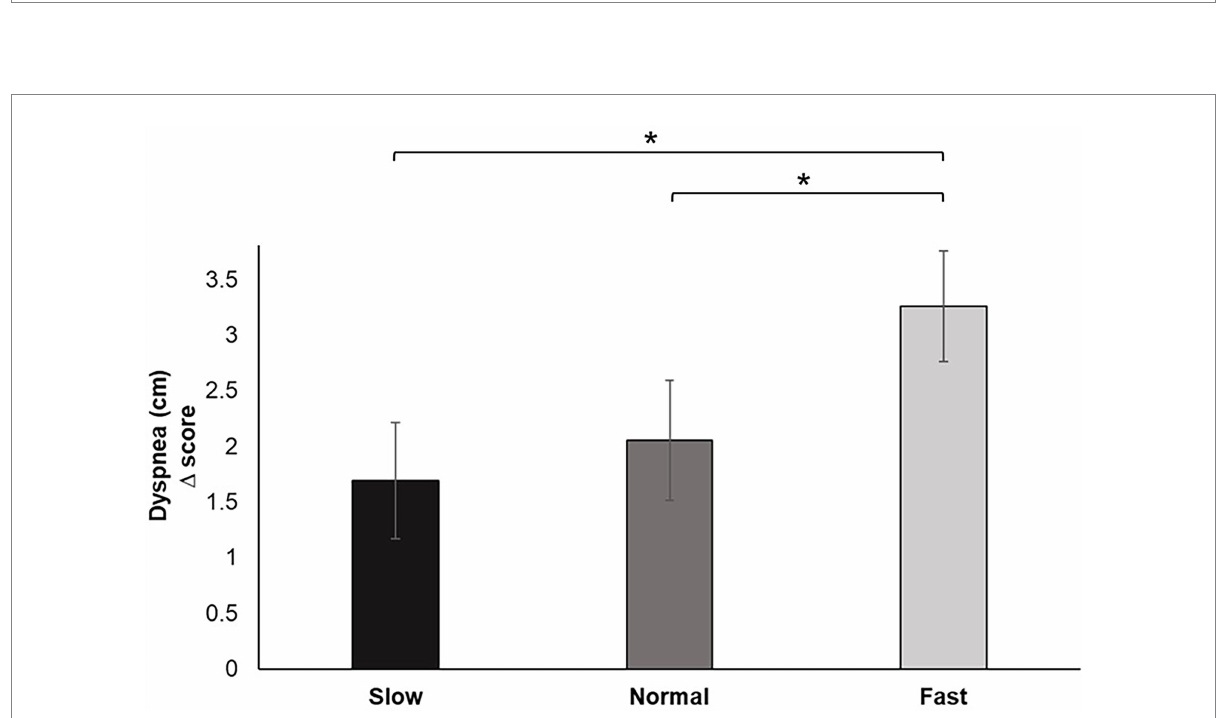
FIGURE 7 Dyspnea change scores for each breathing frequency condition in centimeters (cm) on a scale from 1–10. Greater values indicate increases in perceived dyspnea of breathing to performance of the pinch task. Error bars represent +1 SE from the mean. Asterisks represent significant differences ( p <